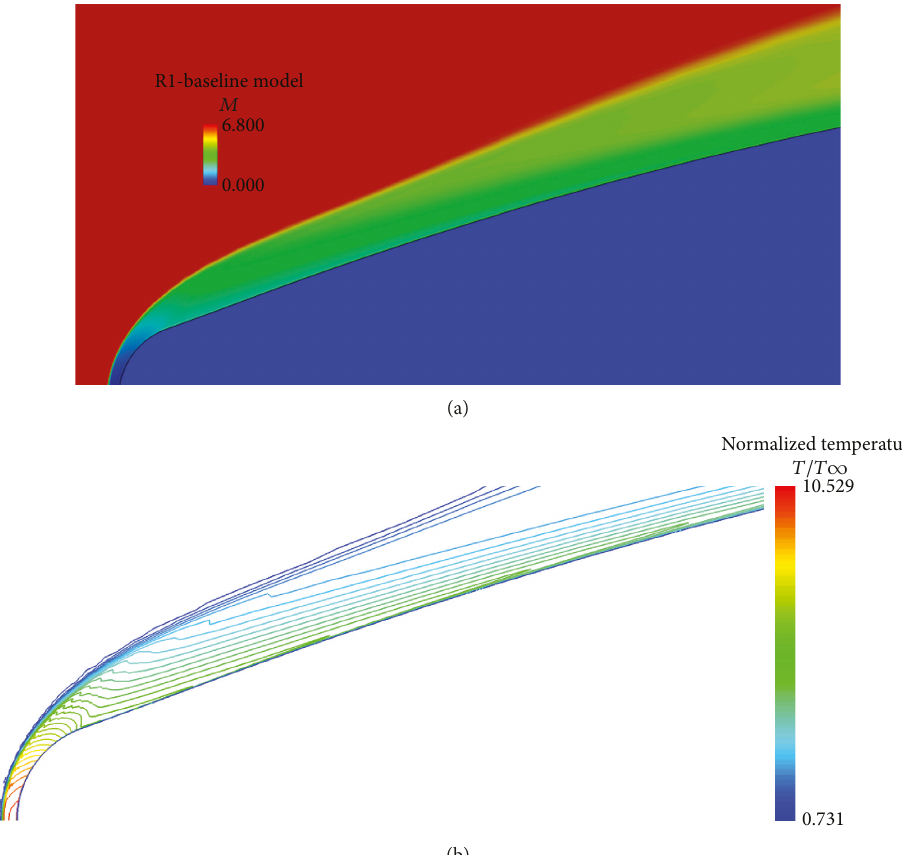
Figure 7: (a) Model R1, Mach number distribution, Re = 4 4 × 10 6 , α = 0 0 ° , M = 6 8 . (b) Model R1, normalized temperature, Re = 4 4 × 10 6 , α = 0 0 ° , M = 6 8